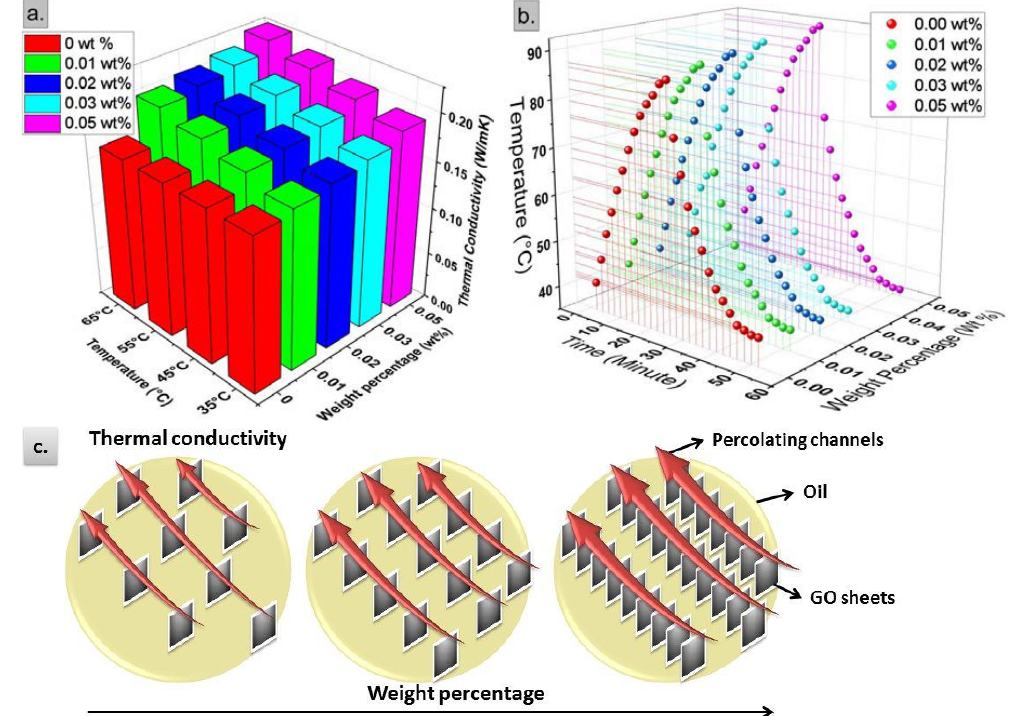
Figure 9. Thermal conductivity enhancements in GO-based CSO nanofluids. ( a ) Thermal conductivity; ( b ) thermal response; ( c ) proposed heat transport mechanism.